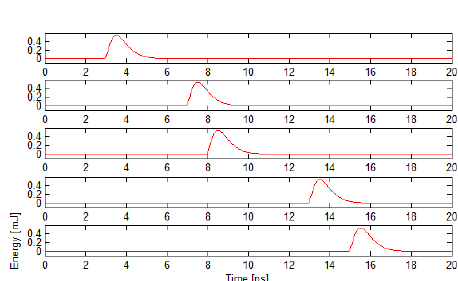
Figure 10. Modified Gaussian pulse model